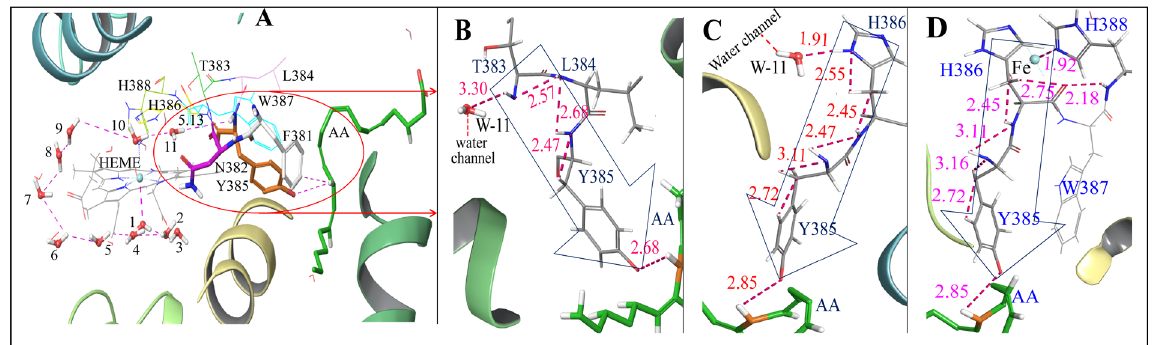
Figure 3. MD studies: ( A ) COX-2–AA–heme complex showing loop of water molecules (1–11) connecting Fe to the peptide through ( B ) T383 ( C ) H386, corresponding to channel ‘a’ and ‘b’, respectively in Fig. 1C for the radical transfer from heme to Y385; ( D ) Connection of Fe with Y385 through H388-H386 corresponding to channel ‘c’ in Fig.